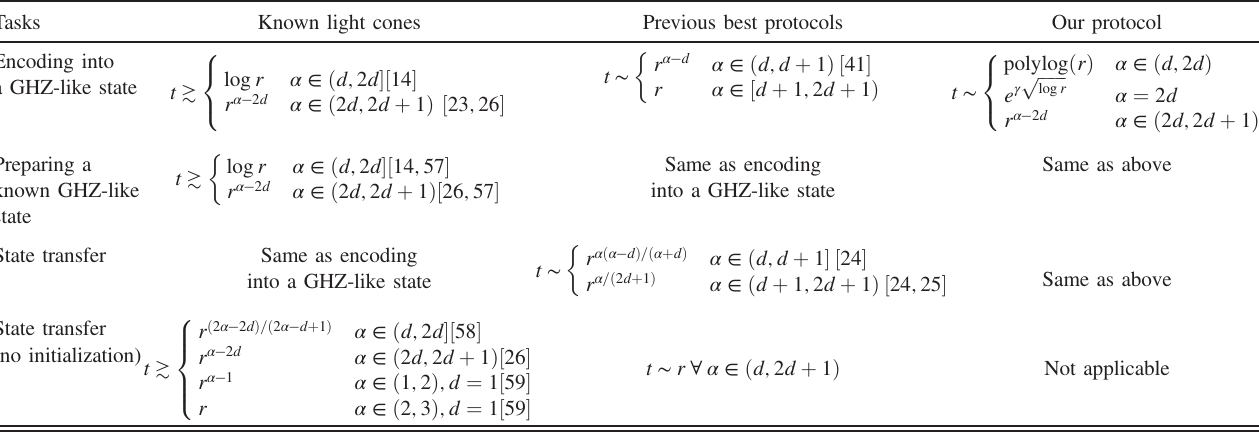
TABLE I. A summary of known bounds and protocols in the regime α ∈ ð d; 2 d þ 1 Þ for several information-propagation tasks: encoding an unknown qubit state into a GHZ-like state (row 1), preparing a known GHZ-like state (row 2), state transfer assuming we can initialize intermediate qubits (row 3), and state transfer given intermediate qubits in arbitrary states (i.e., so-called universal state transfer [24], row 4). The tasks of encoding information into GHZ-like states, preparing a known GHZ-like state, and quantum state transfer with initialization are constrained by the Lieb-Robinson bounds. On the other hand, state transfer given intermediate qubits in arbitrary states (i.e., universal state transfer) is more difficult than state transfer with initialized intermediate qubits and is bounded by the more stringent Frobenius light cone [24]. The bounds on encoding information into GHZ-like states (except Ref. [23]) also apply to general k -body interactions. All listed bounds also hold not just for qubits, but for all finite-level systems. For d < α < 2 d þ 1 , our protocol saturates (up to subpolynomial corrections) the known bounds, thus proving the optimality of both the protocol and the